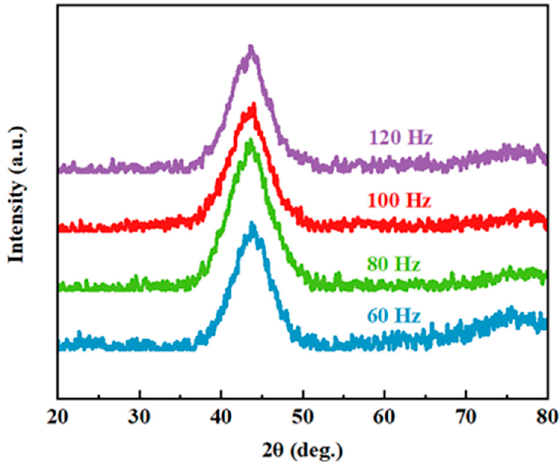
Figure 3. X-ray diffraction patterns of the laser-processed coating samples with different scanning Figure 3. X ‐ ray diffraction patterns of the laser ‐ processed coating samples with different scanning frequencies (60 Hz, 80 Hz, 100 Hz and 120 Hz). frequencies (60 Hz, 80 Hz, 100 Hz and 120